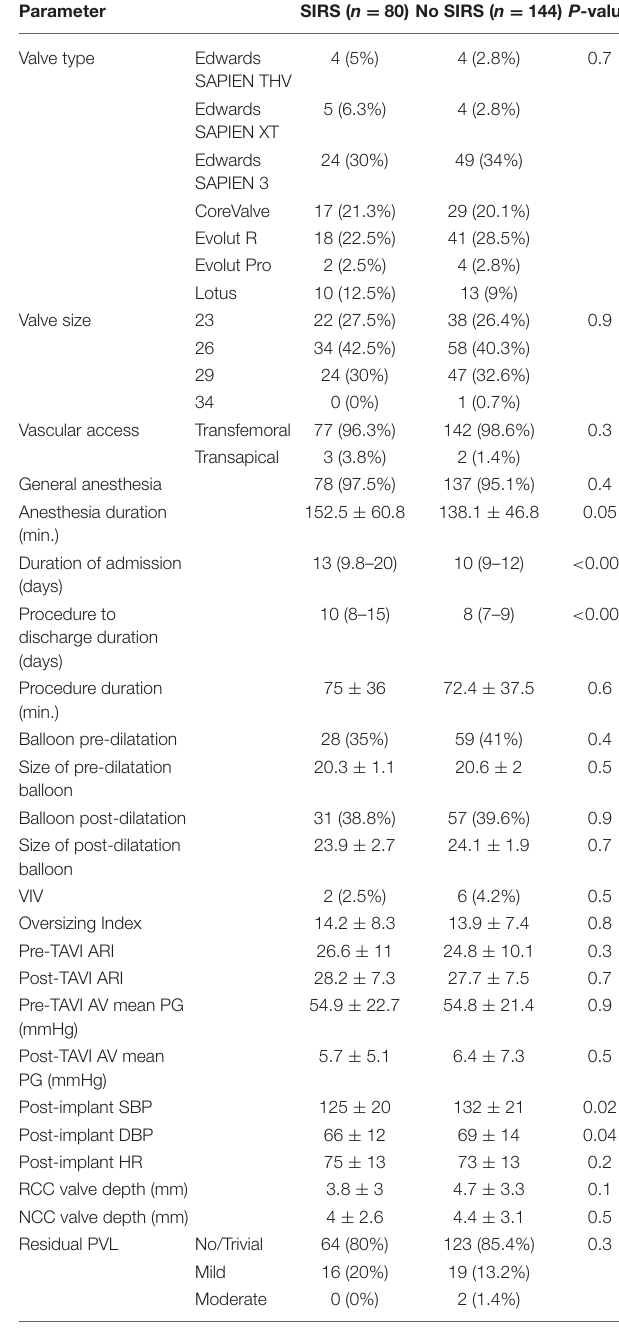
TABLE 3 | Procedural characteristics.